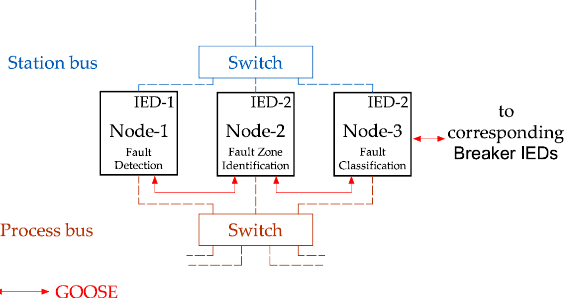
Figure 8. Fault detection node, fault classification node, and zone identification node.